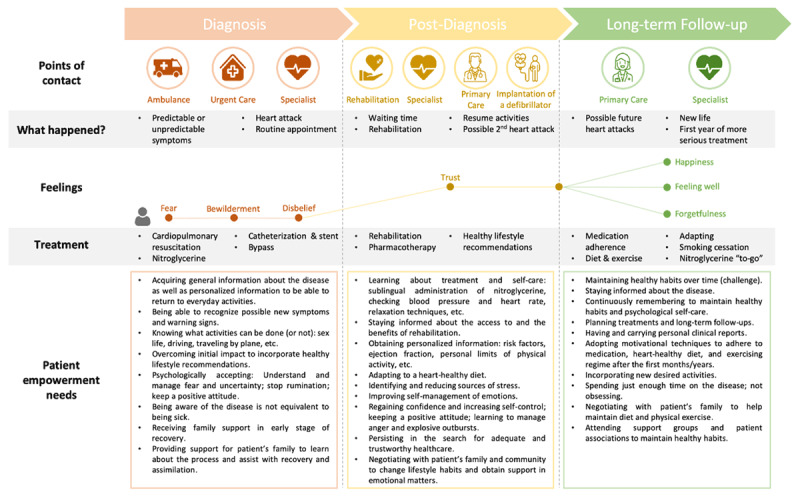
Patient Journey Map.